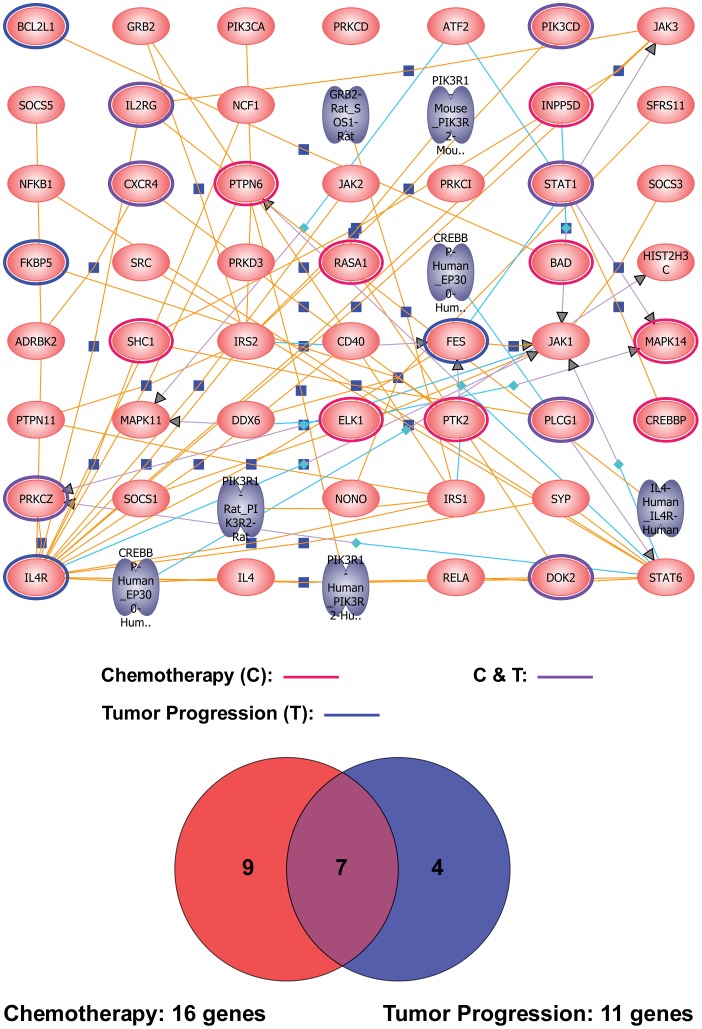
The IL4 pathway was enriched in both tumor progression and chemotherapy signatures.Eleven out of the 49 IL4 pathway-involved genes were mapped in the pathway enrichment analysis for the 3,858 differentially expressed transcripts in PBMC among patients with advanced non-small ell lung cancer (NSCLC) and normal controls, whereas 16 unique genes were mapped for the 669 differentially expressed transcripts in PBMC of patients with advanced-stage NSCLC before and after chemotherapy. Seven intersected genes between the two gene-sets were identified and presented in a Venn diagram. The blue circle indicates differentially expressed genes associated with tumor progression solely, the red circle with chemotherapy solely, and the purple circle with both effects.